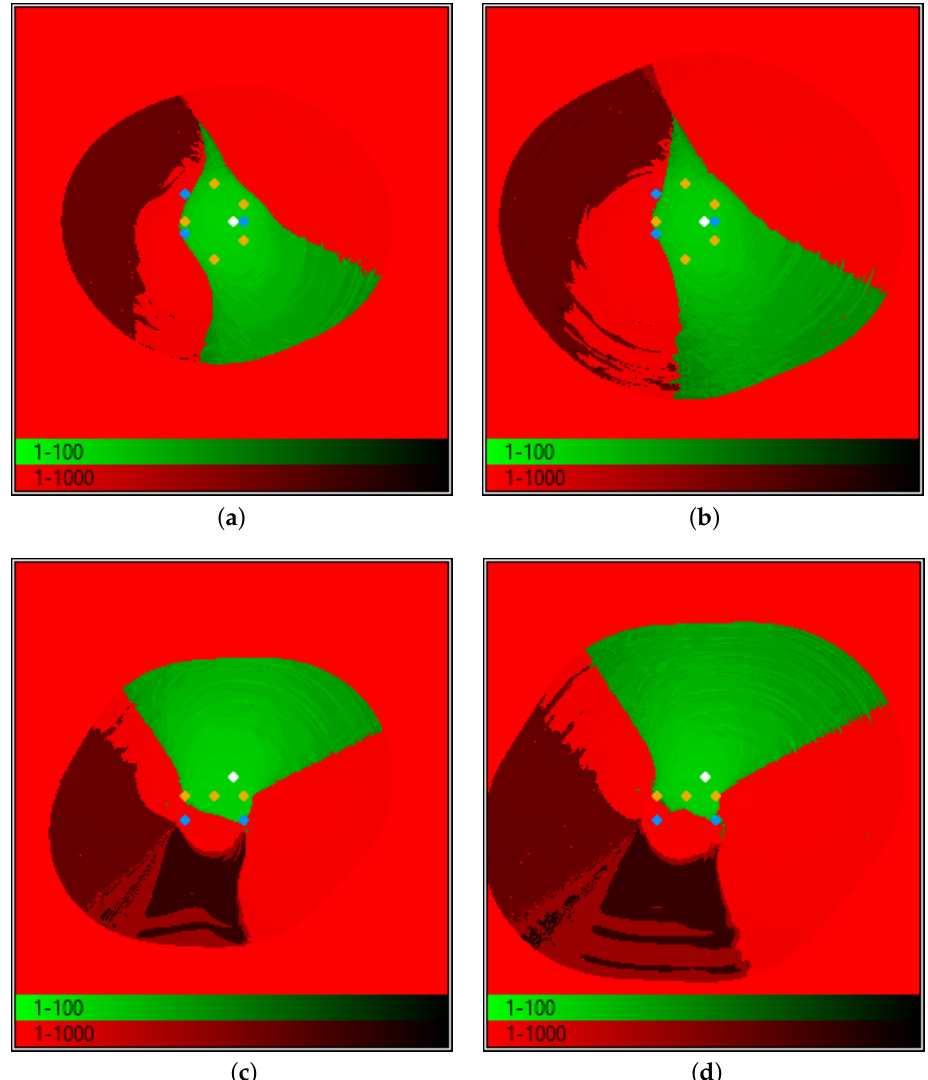
Figure 8. 2D convergence maps of xy ( a , b ) and xz ( c , d ) sections. The remaining 7 parameters are set to their exact values ( a , c ) or to their default values ( b , d ). The target (white dot) is in a more peripheral position (larger distance from the array axis), with respect to the case of Figure 7, at z = 31 mm. It is confirmed that using wrong guesses for (cid:126) B g and (cid:126) m and wrong (larger) z makes the ( x , y ) convergence area larger than using the exact